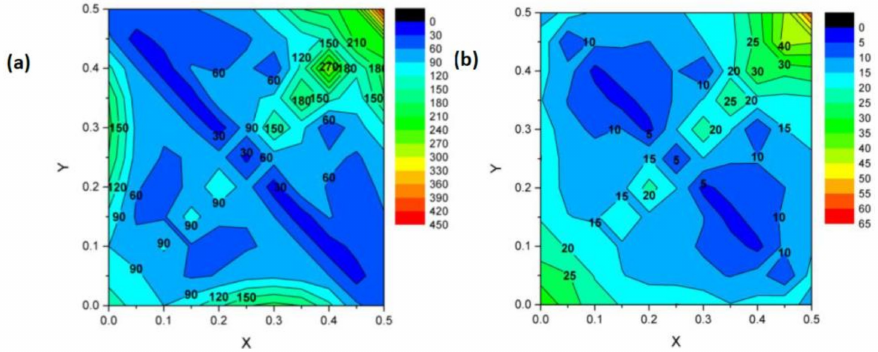
Figure 5. Stress concentration factor K as a function of (x, y) for two radii: ( a ) r = 0.05 a and ( b ) r = 0.1